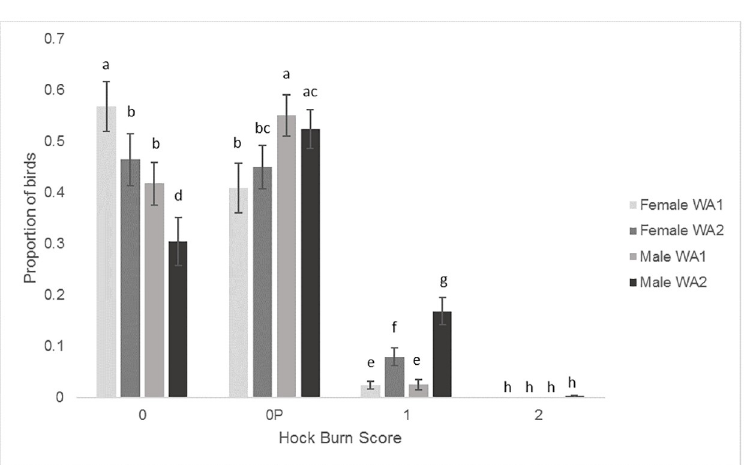
Fig 5. Mean proportions ( ± SEM) of the different hock burn scores for female and male birds during welfare assessment (WA) 1 and 2. Different letters denote signicant differences (P < 0.05).